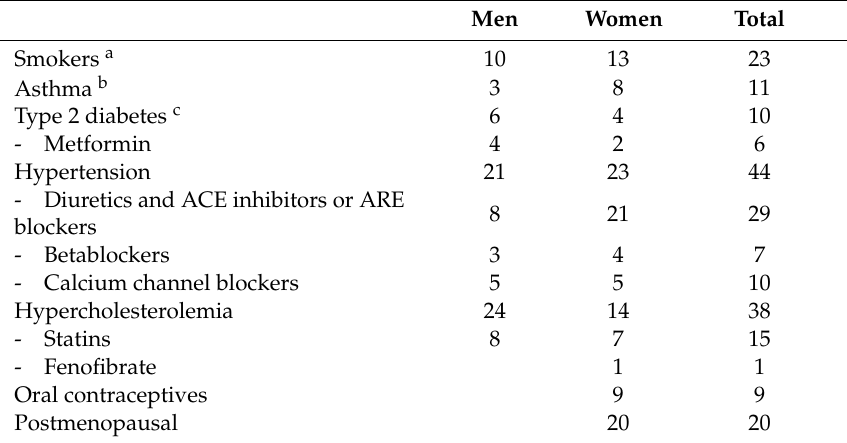
Table 2. Medical treatments, menopausal state, and